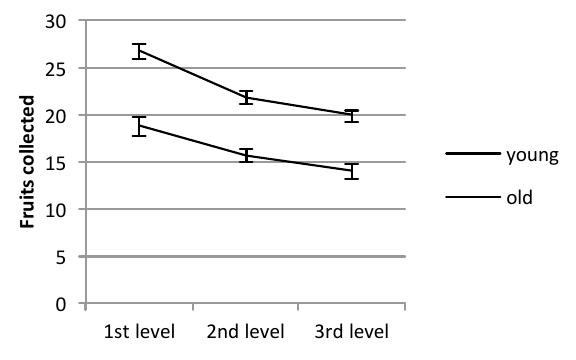
Figure 2. Performance over three levels by